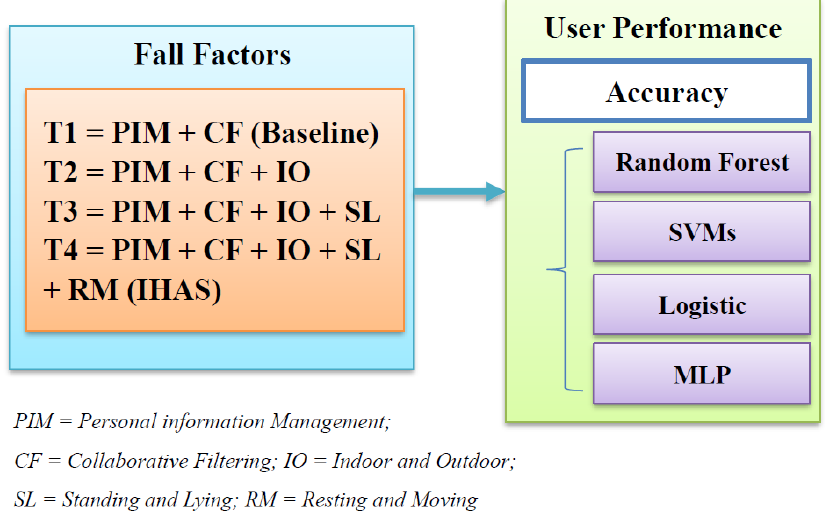
Figure 2. The Research Model.